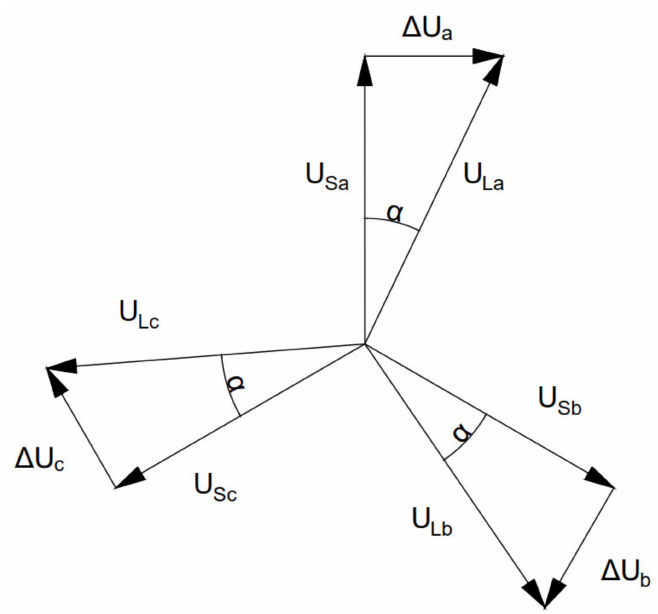
Figure 1. Phasor diagram for the asymmetrical direct PST.